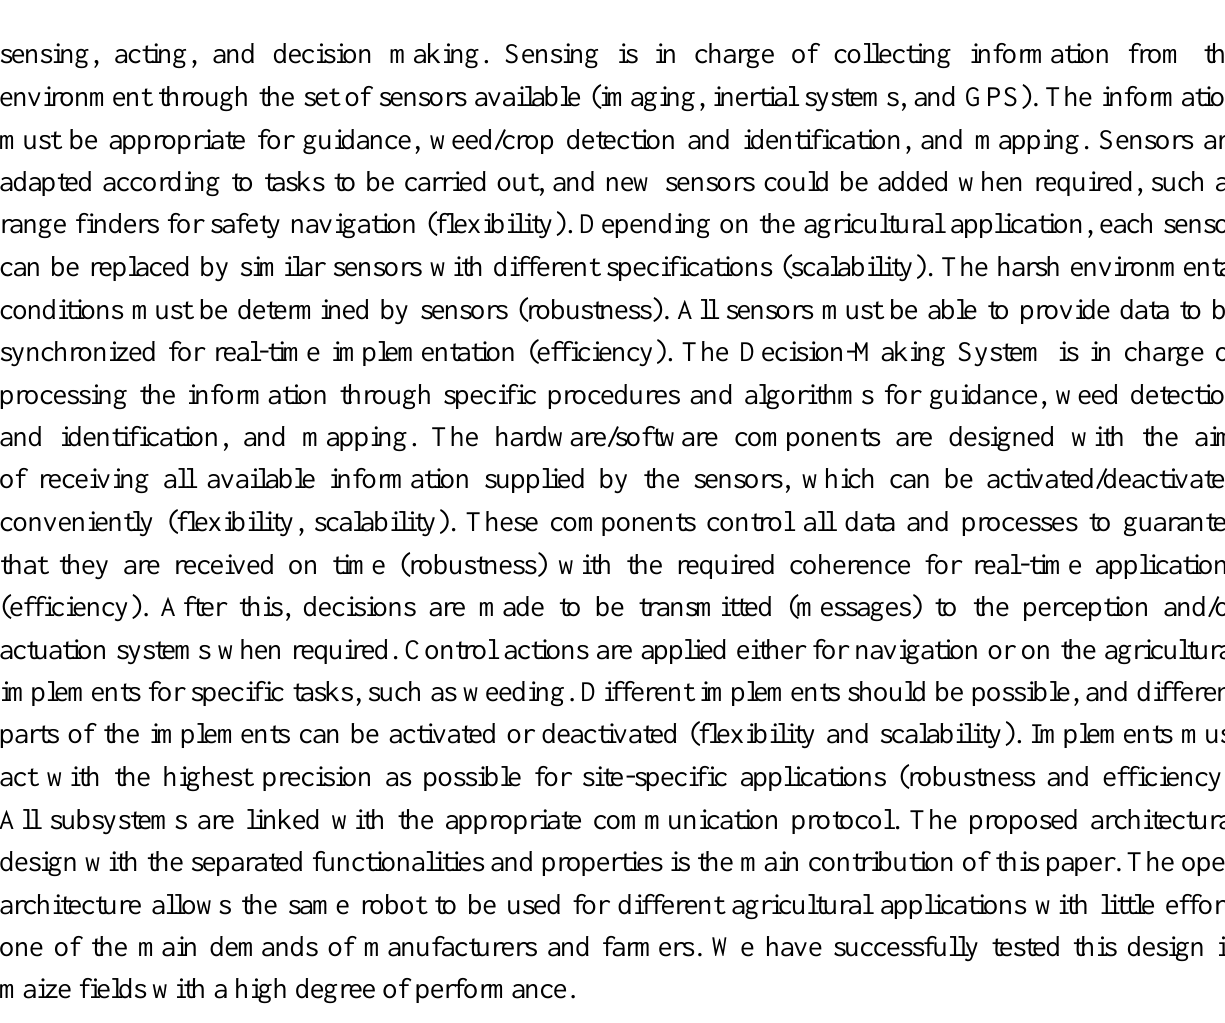
Figure 1. Architectural design: perception (sensing), actuation, and decision